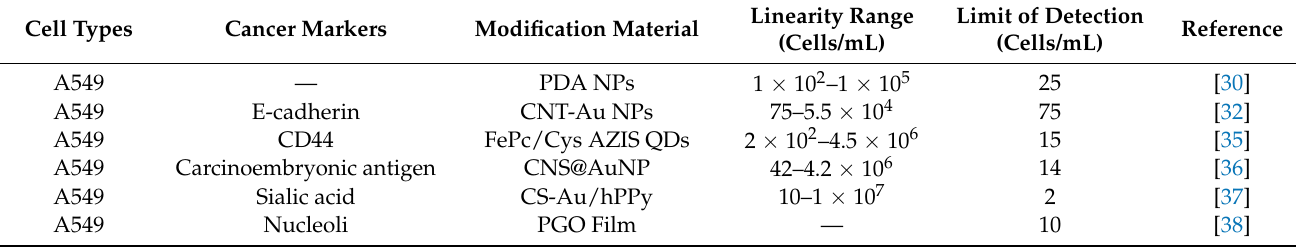
Table 2. Electrochemical cytosensors used for lung cancer cell